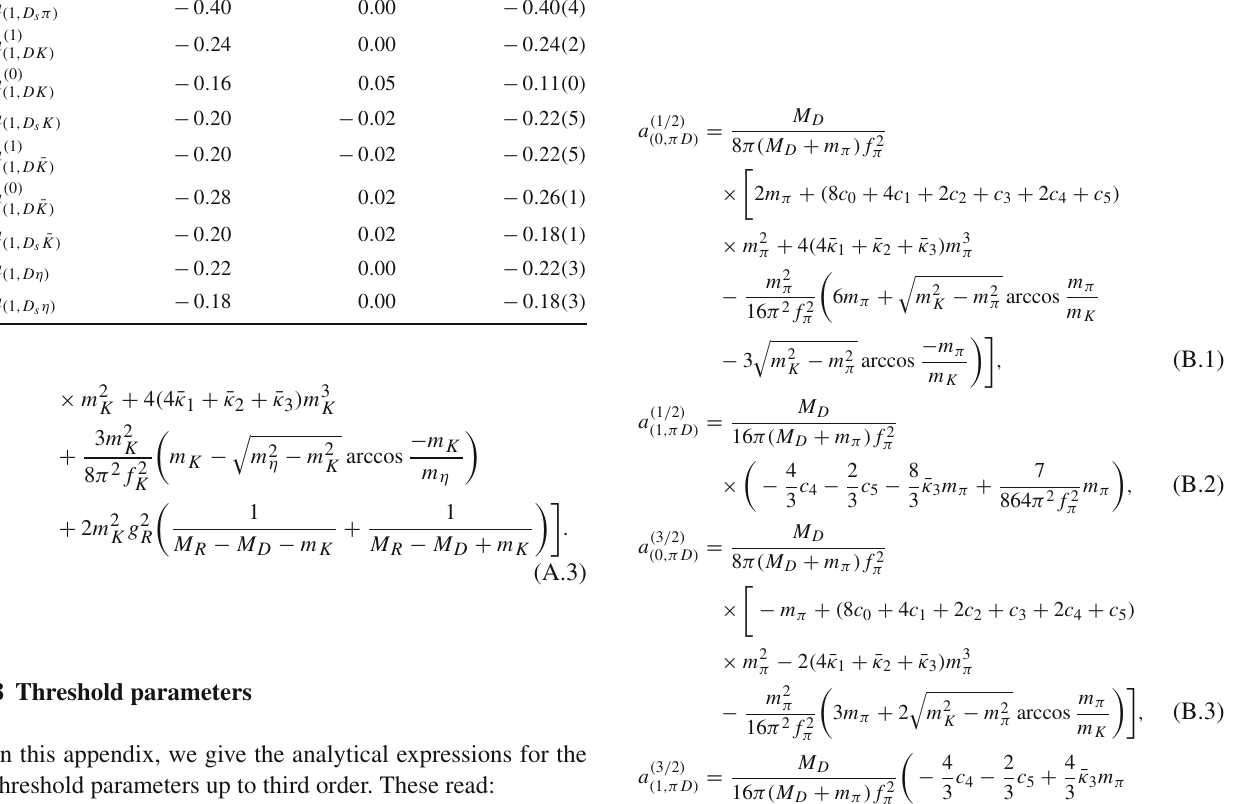
( 2317 ) -exchange Born-term contribution. The Fig. 7 The leading D ∗ s 0 ( 2317 ) , D meson, double solid, solid and dashed lines represent D ∗ s 0 and kaon, respectively. The crossed diagram is not